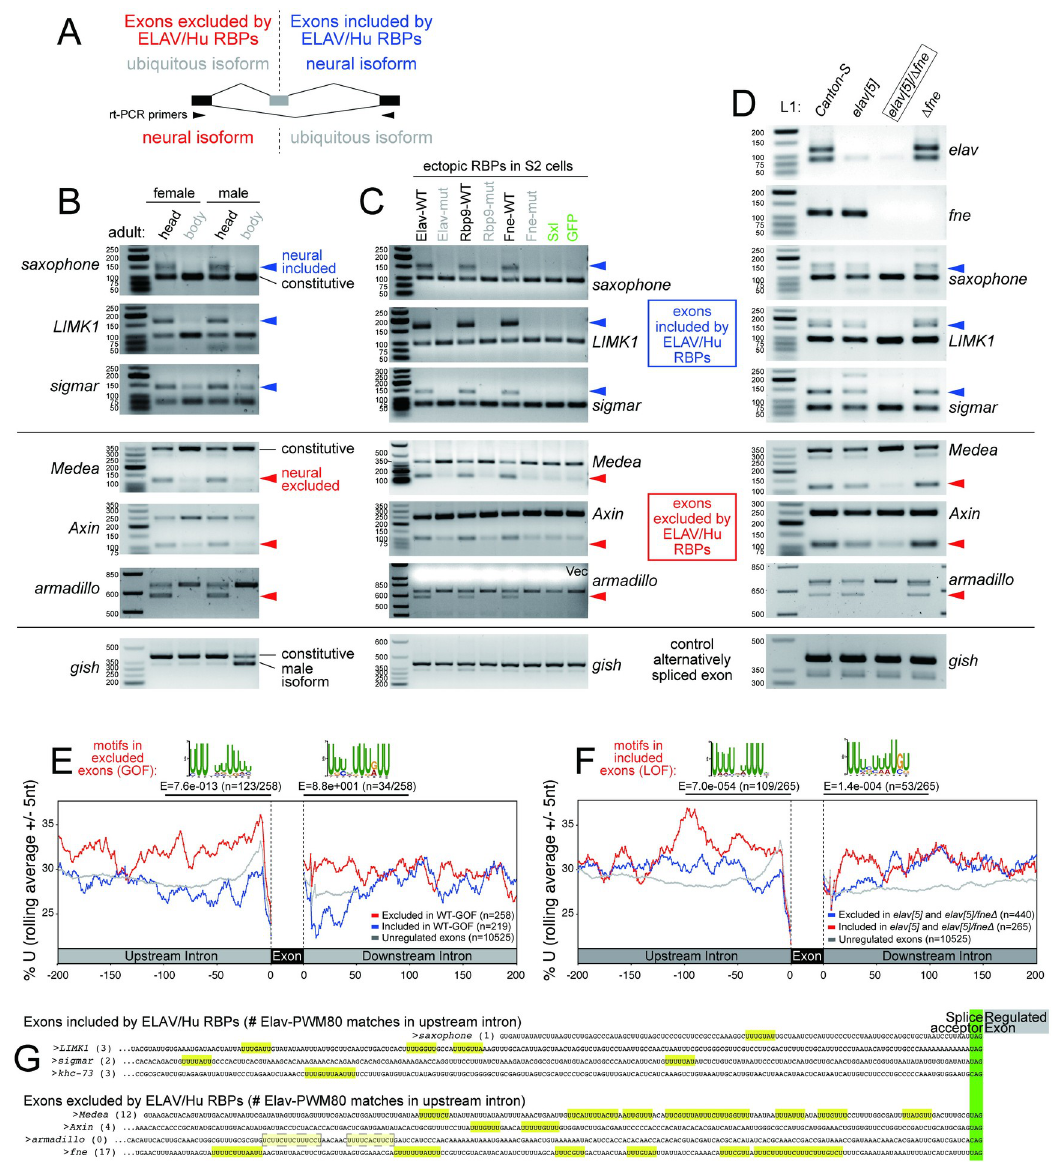
Fig 3. Experimental validation of neural-specific cassette exon splicing regulated by ELAV/Hu family RNA binding proteins. (A) Experimental design and rt-wPCR primers to test neural specific cassette exon splicing. All rt-PCR tests were conducted at least twice with independent RNA samples with similar results; the data shown here are representative. B) rt-PCR validation of cassette exon inclusion ( saxophone , LIMK1 , sigmar ) and exclusion ( Axin , Medea , armadillo ), no change ( gish ) gene candidates in adult fly tissue samples. (C) rt-PCR validation of cassette exon inclusion ( saxophone , LIMK1 , sigmar ) and exclusion ( Axin , Medea , armadillo ), no change ( gish ) gene candidates in S2R+ cells transfected with wildtype and RRM-mutant ELAV/Hu RBPs, together with another U-rich binding protein Sxl. (D) rt-PCR validation of cassette exon inclusion ( saxophone , LIMK1 , sigmar ) and exclusion ( Axin , Medea , armadillo ), no change ( gish ) gene candidates in Canton-S and single or double mutant 1 st instar larvae (L1). (E) Global analysis of exons excluded by mis-expression of ELAV/Hu RBPs shows U-enrichment in flanking intronic regions, especially in the upstream regions. Comparable U-enrichment is not seen in the vicinity of exons that are included by ELAV/Hu factors. De novo motif analysis shows the top enrichment sequence matches the ELAV/Hu binding site. (F) Global analysis of exons included in elav and elav/fne mutant L1-CNS, compared to Canton-S , shows similar positional enrichment of intronic uridine and Elav binding sites. (G) Elav binding motifs found in upstream intron region of exon inclusion and exclusion gene candidates regulated by ELAV/Hu family RBPs (highlighted in yellow, at least 80% matches to the Elav position weight matrix [Elav- PWM80]). There is typically much greater density of ELAV/Hu motifs upstream of excluded exons, compared to included exons.